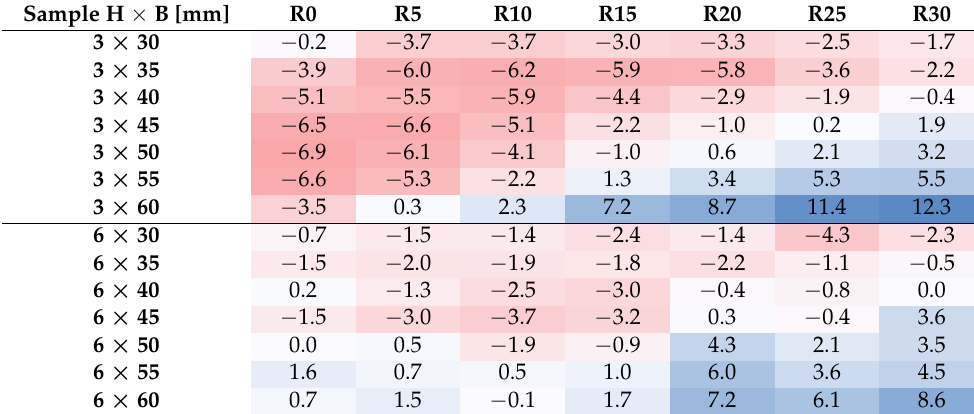
Table 6. Summary of the results of calculating the torsional moment [Nm] of unexpanded test sets using analytical, numerical and experimental methods.